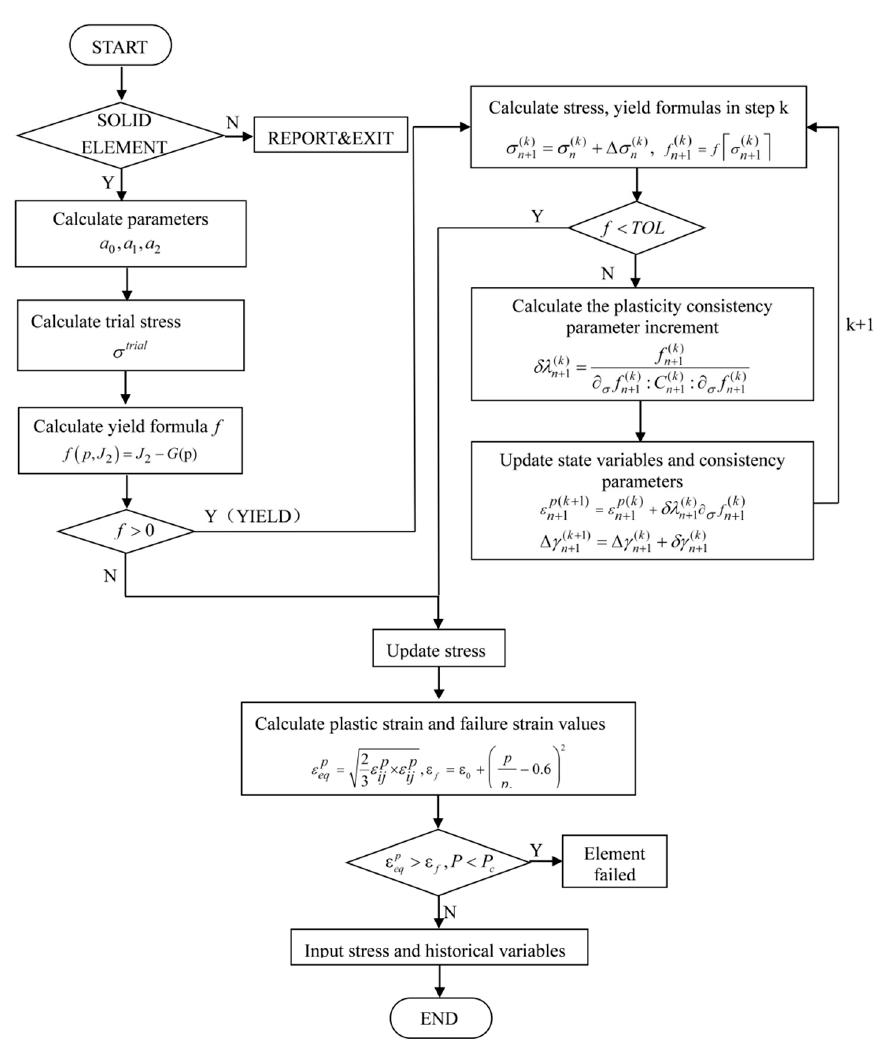
Figure 2. Stress update algorithm flow.